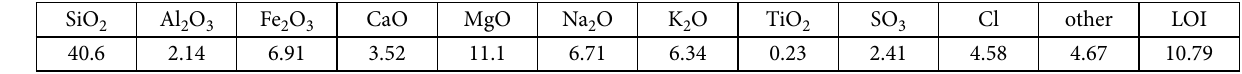
Figure 2. Plastic and liquid limits of clay Table 1. Chemical composition of fly ash, %